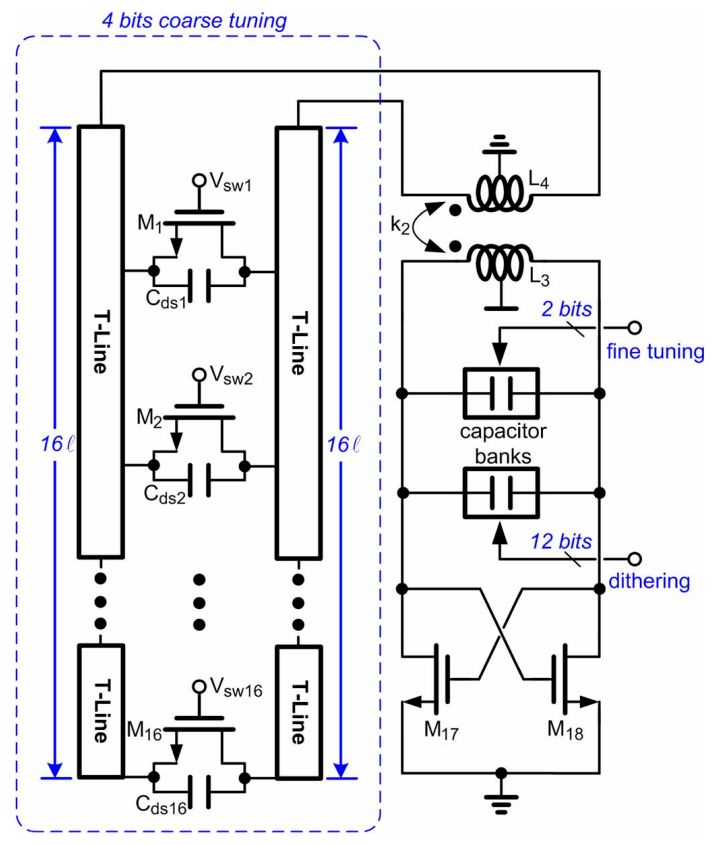
Figure 16. The circuit schematic of DCO